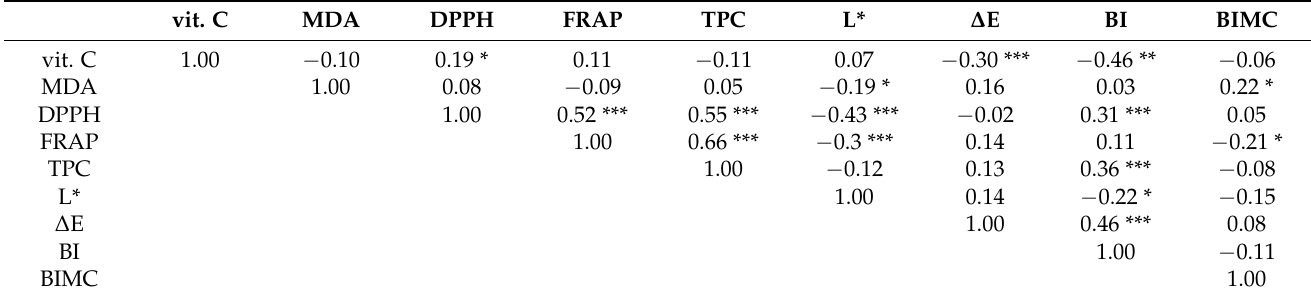
Figure 3. Total phenolic compounds (TPC) ( A ), Vitamin C ( B ) and antioxidant capacity DPPH ( C ) and FRAP ( D ) measured in Agaricus bisporus packed with active packages containing zeolite (FZ), aҫai extract (FE), aҫai extract + zeolite (FEZ) in MAP, without active packaging in MAP ( C ) and wrapped in polyvinyl chloride foil (PVC). Standard error is presented in a form of horizontal bars. Table 2. Pearson’s correlation coefficients of mushrooms quality parameters between total phenol (TPC), vitamin C (vit. C), malondialdehyde (MDA) contents, antioxidant activity (DPPH, FRAP), lightness (L*), color change ( ∆ E), browning index (BI) and browning measured inside mushrooms cap